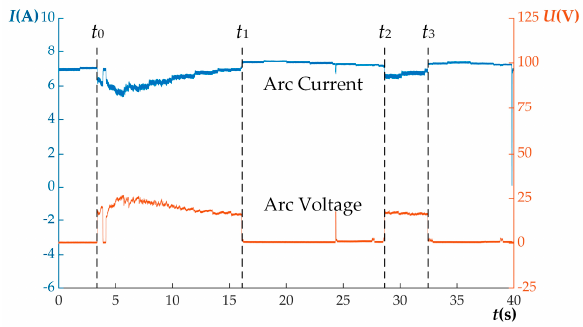
Figure 5. Spontaneous arc-extinguishing phenomenon due to thermal expansion of electrodes.